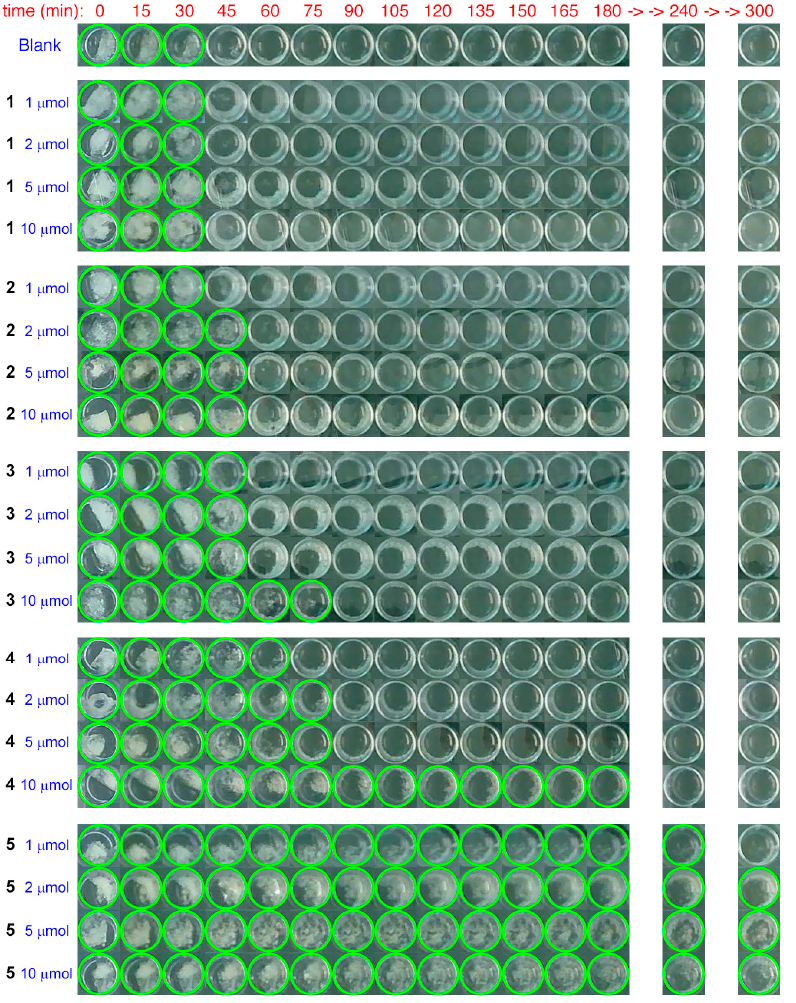
Figure 1. Time evolution of prepared hydrogels at 37 °C. Images of the sealed wells were caught every 15 min. When hydrogel consistence is maintained the well is circled in green (original video frames are presented in the Supplementary Materials).